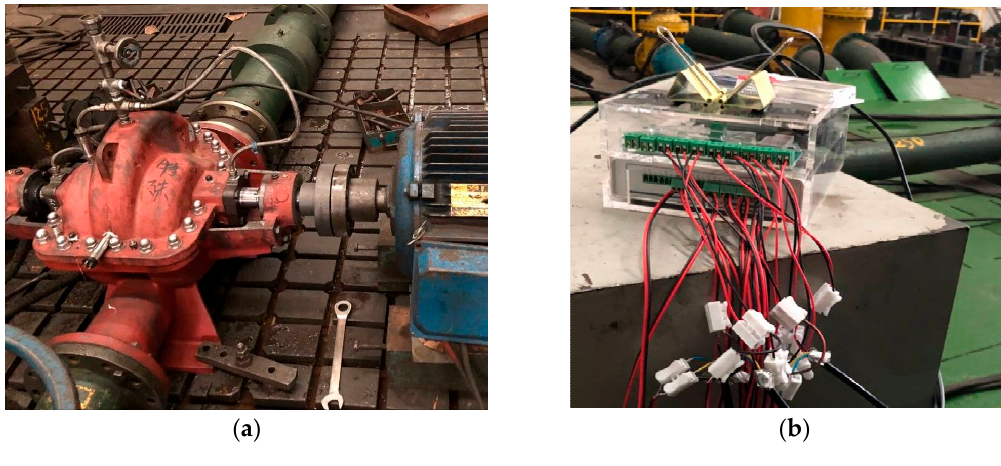
Figure 5. Test Pump (a) and Data Acquisition Device (b) .